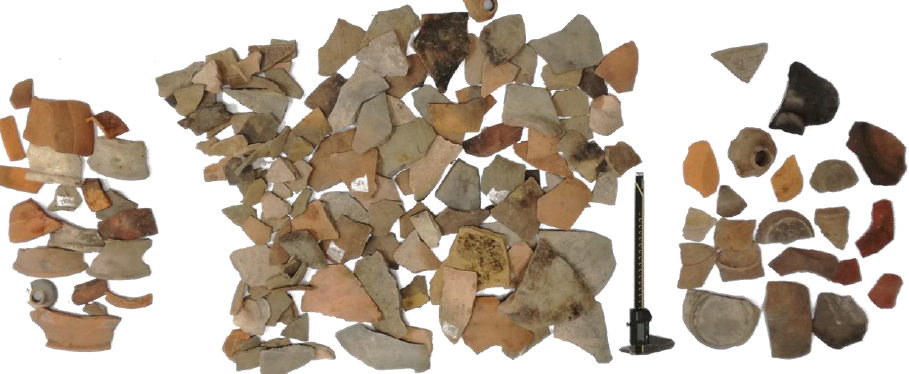
Figure 10. The collection of potsherds from Alba Fucens excavation.